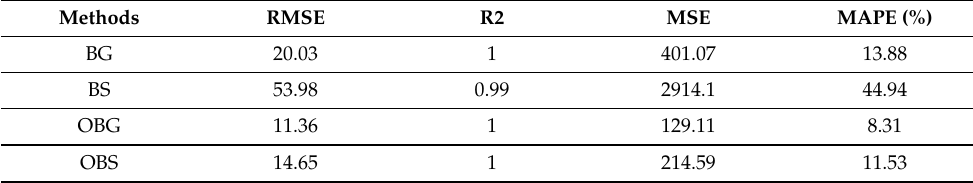
Table 6. Evaluation scores of the prediction using testing